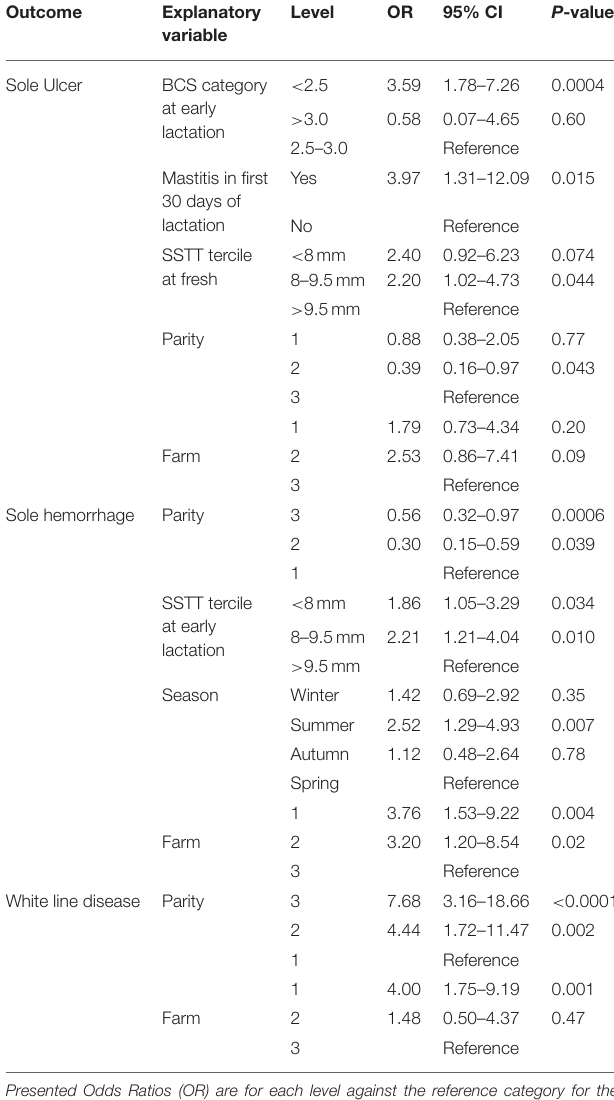
Presented Odds Ratios (OR) are for each level against the reference category for the odds of developing SU, SH, or WLD; P-values and 95% confidence intervals (CI) are Wald based